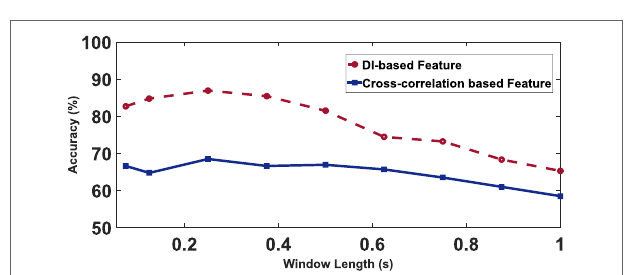
FIGURE 11 | Accuracy of train direction prediction: (a) red line: using directed information as features; (b) blue line: using cross-correlation coefficients features